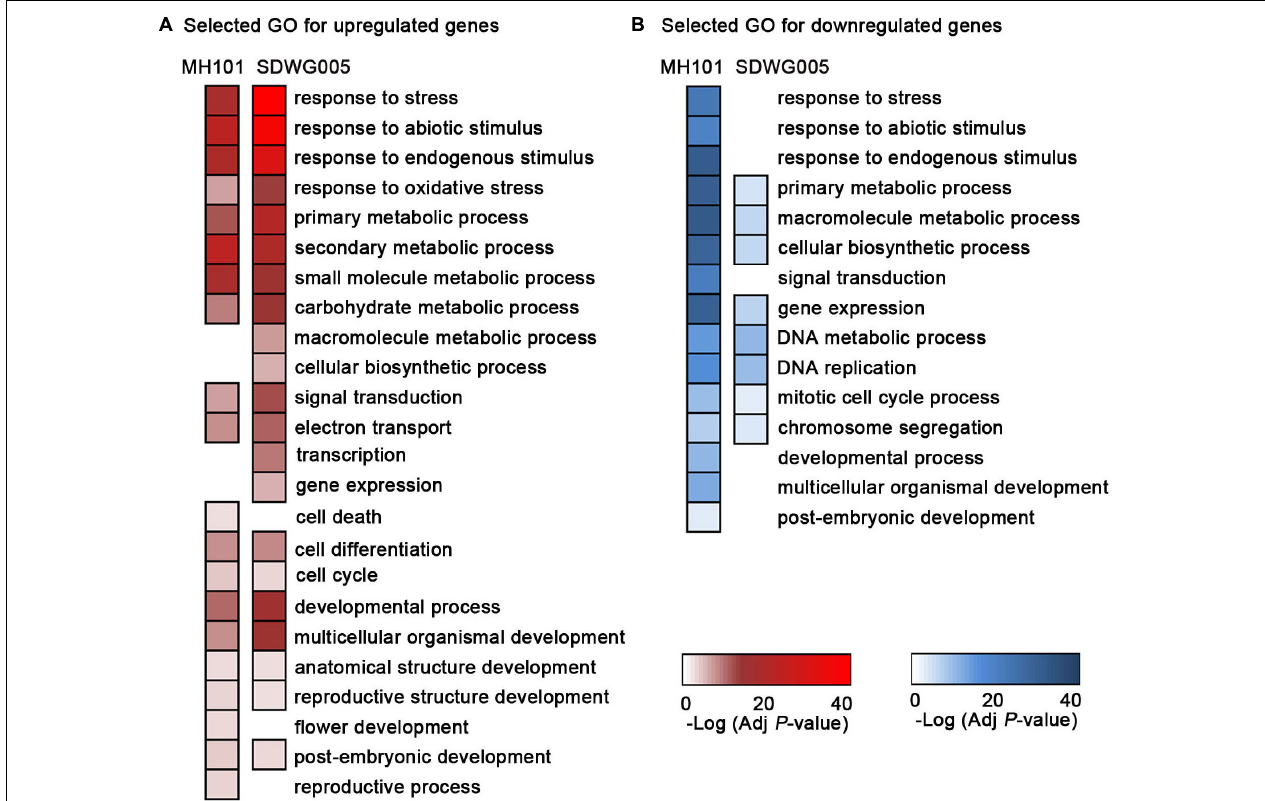
FIGURE 5 | GO enrichment analysis of DEGs for the biological process using AgriGO. Most representative enriched GO categories from the up-regulated DEGs (A) or down-regulated DEGs in rice spikelets upon heat stress (B) , respectively. Color bars: -log 10 transformed P -value (adjusted by Benjamini-Hochberg).